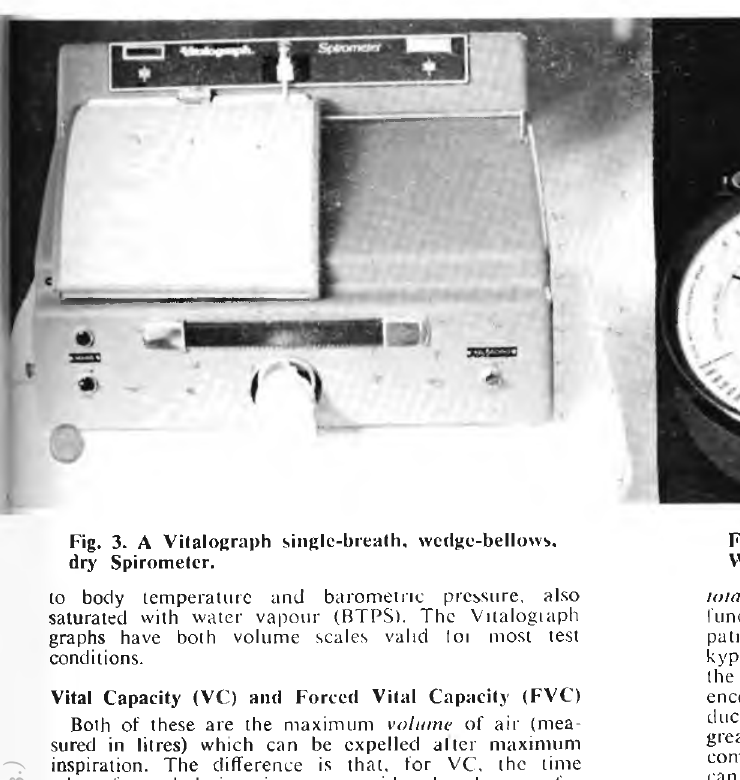
Fig. 3. A Vitalograph single-breath, wcdge-bellows, dry Spirometer. to body temperature and barometric pressure, also saturated with water vapour (BTPS). The Vitalogiaph graphs have both volume scales valid loi most test conditions.